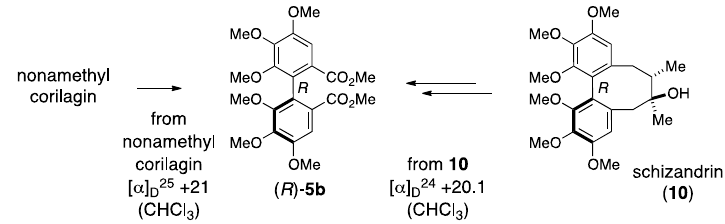
Figure 5. The determination of the R -axial chirality in the latest structure of corilagin.